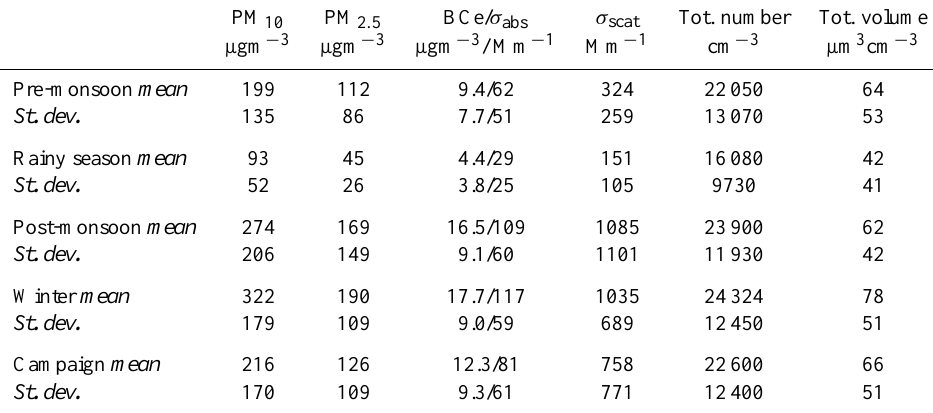
Table 2. Mean and standard deviation for PM masses, equivalent black carbon (BCe), absorption coefficient ( σ abs ), scattering coefficient ( σ scat ), total number concentration, and total volume concentration during different seasons. PM 10 PM 2 . 5 BCe/ σ abs σ scat Tot. number Tot. volume µgm − 3 µgm − 3 µgm − 3 / Mm − 1 Mm − 1 cm − 3 µm 3 cm − 3 Pre-monsoon mean 199 112 9.4/62 324 22050 64 St. dev. 135 86 259 Rainy season mean 93 45 Post-monsoon mean 274